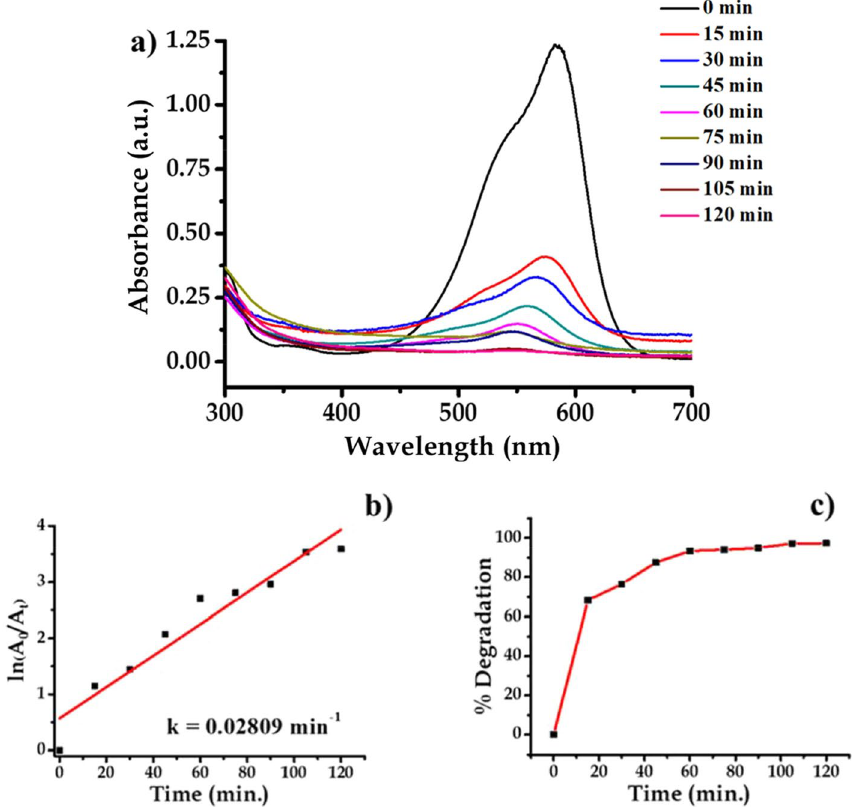
Figure 21. UV–Vis absorption spectra of ( a ) crystal violet, ( b ) kinetics of catalytic reduction and ( c ) percentage degradation of crystal